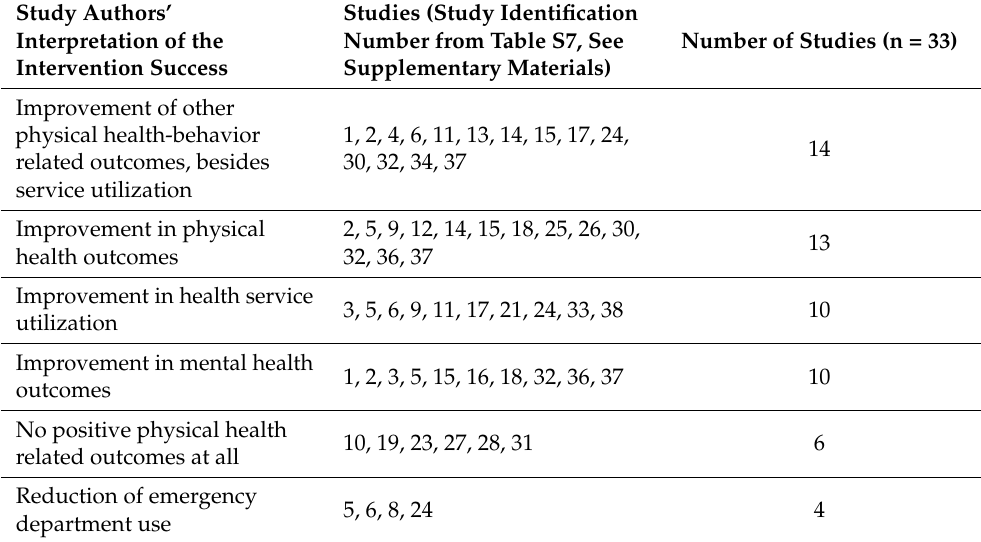
Table 3. Study authors’ interpretation of the success of the interventions to promote the utilization of physical health care for people with a